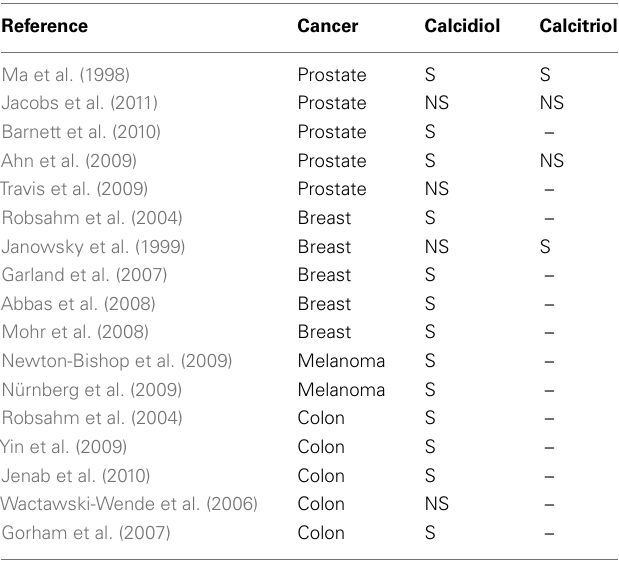
Table 2 | Studies evaluating the association between vitamin D metabolites and cancer in